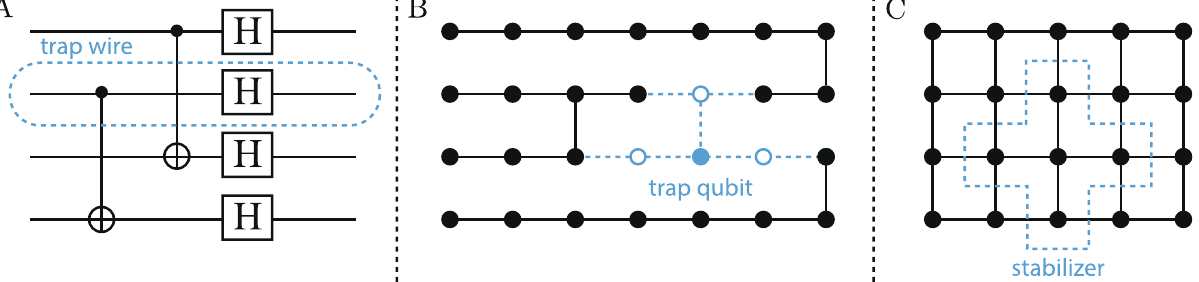
Fig. 2 Approaches to verifying blind quantum computation. a The approach taken to veri fi cation in refs. 10 and 20. The client chooses the computation such that with some fi xed probability each logical qubit may be a “ trap ” , for which the outcome can be easily computed by the client and used to detect any deviation from the protocol by the server. b In ref. 21, individual physical qubits, rather than logical qubits, are used as traps. By hiding Z -basis measurements on the neighbouring qubits the client can surreptitiously disentangle a chosen qubit from the rest of the resource state. The net result is that the outcome for the measurement of the trap qubit in an honest run of the protocol is known in advance by the client, and hence can be used to verify that the server has not introduced an error into the computation. c In the setting where the client performs adaptive measurements on a fi xed resource state, performing measurements on the received qubits to ensure that they satisfy the same stabiliser relations as the ideal resource offers an alternative mechanism to ensure that the server behaves honestly. This approach was initially proposed in ref.